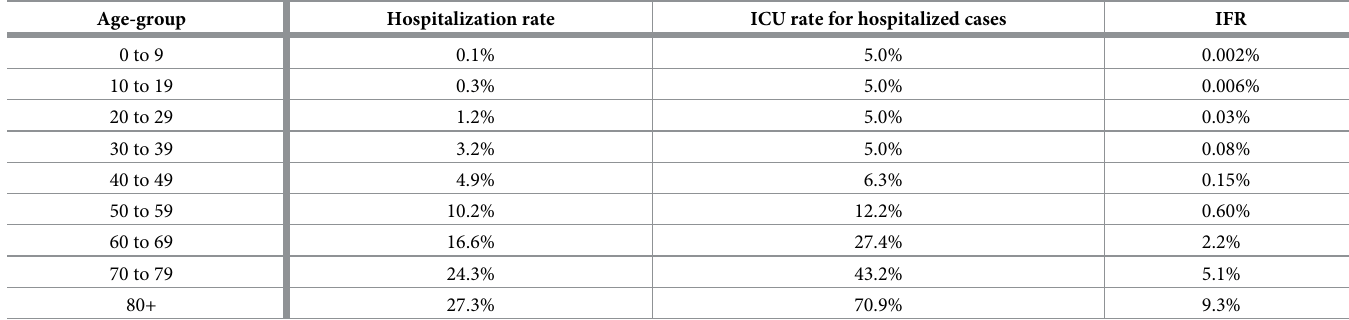
Table 1. Mortality/ICU rates by